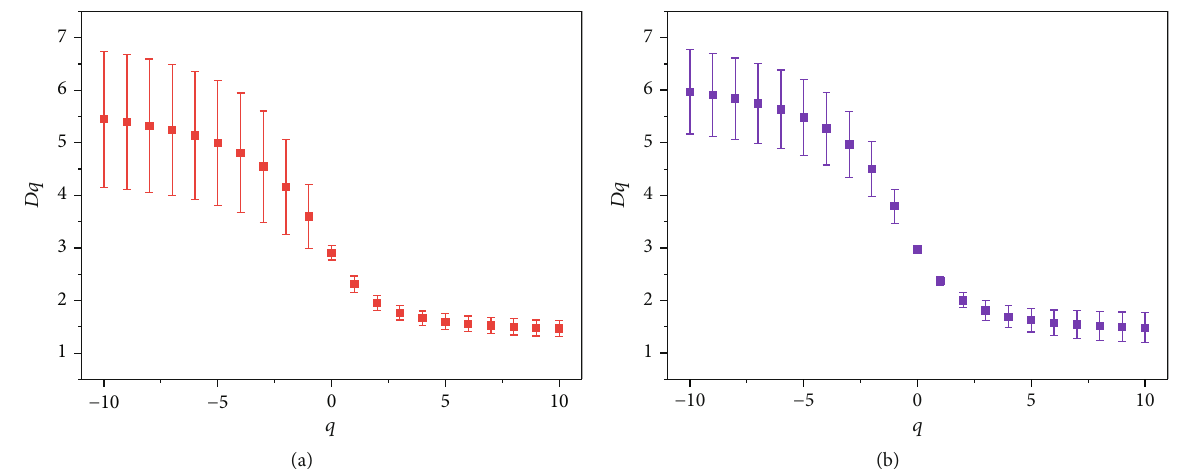
Figure 7: The generalized dimension ( Dq ) versus variable q computed from nitrogen adsorption. (a) SM lithofacies. (b) MS lithofacies. The error bars represent the standard deviation of measurements in twelve separate sample